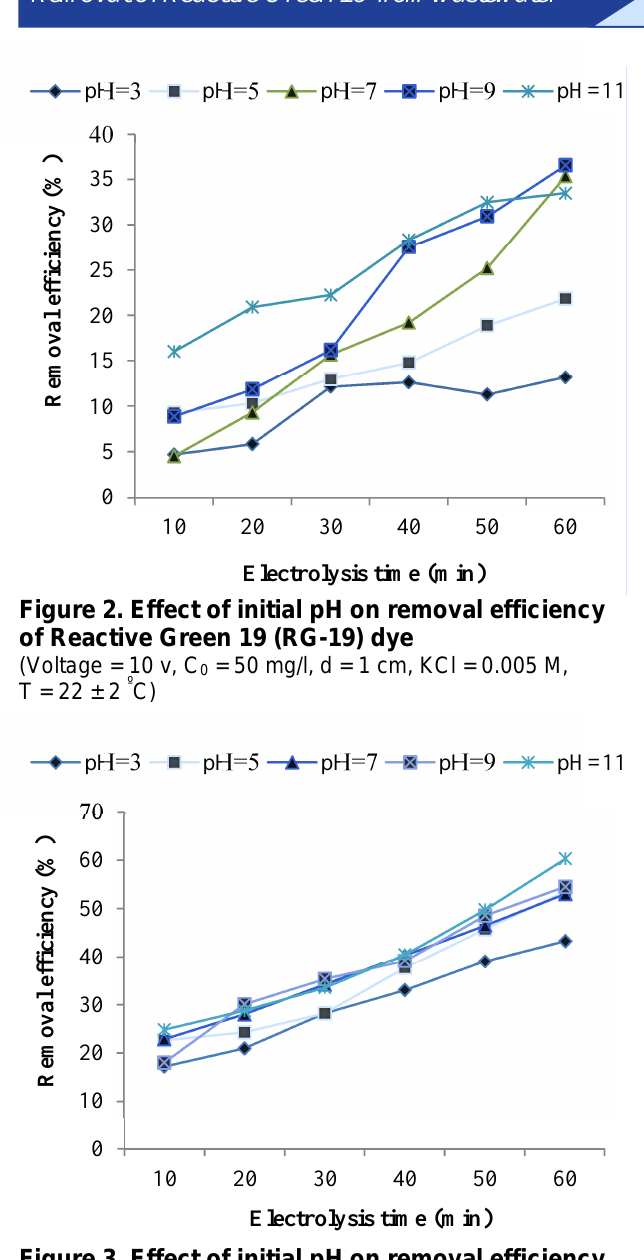
Figure 5. Effect of initial pH on removal efficiency of Reactive Green 19 (RG-19)